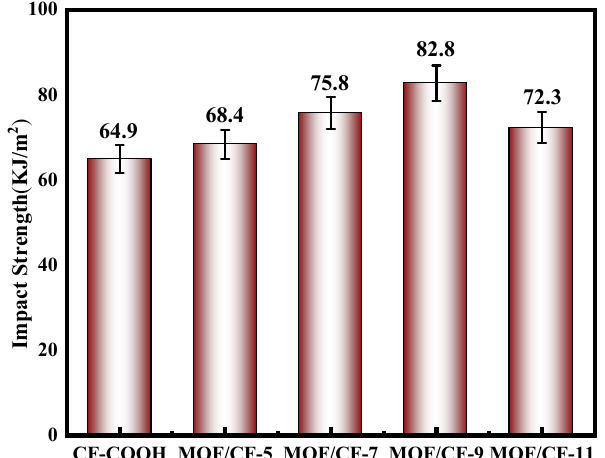
Figure 9. Impact strength of MOF/CF epoxy composites .